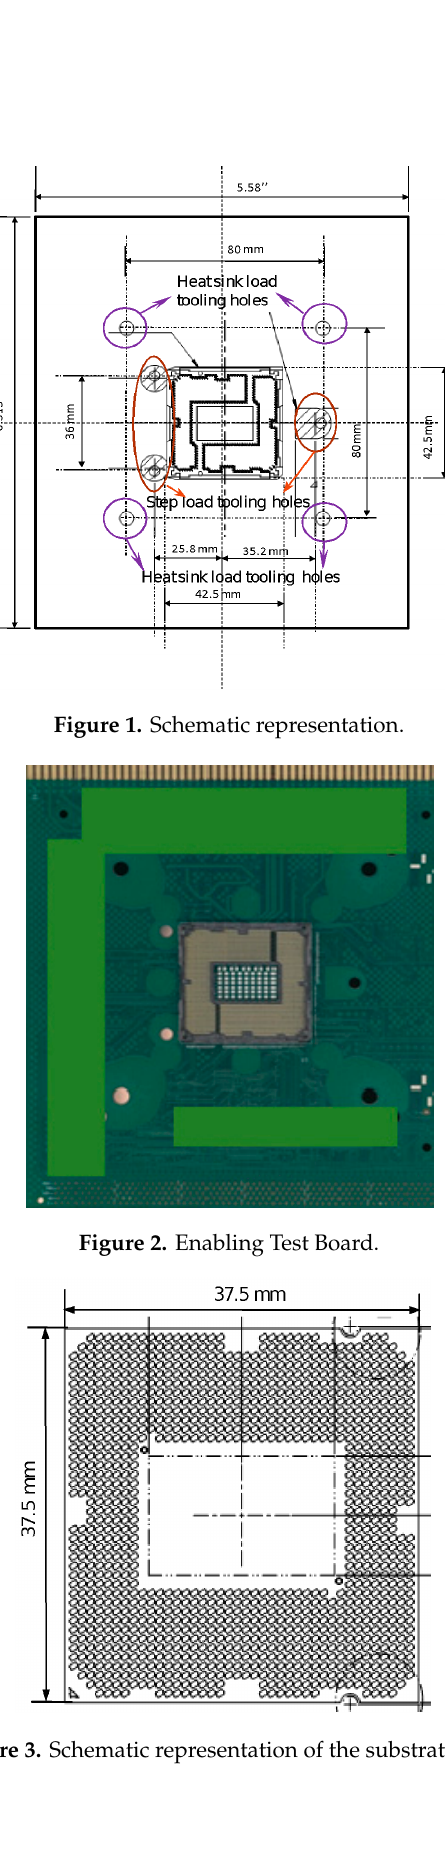
Figure 3. Schematic representation of the substrate size.